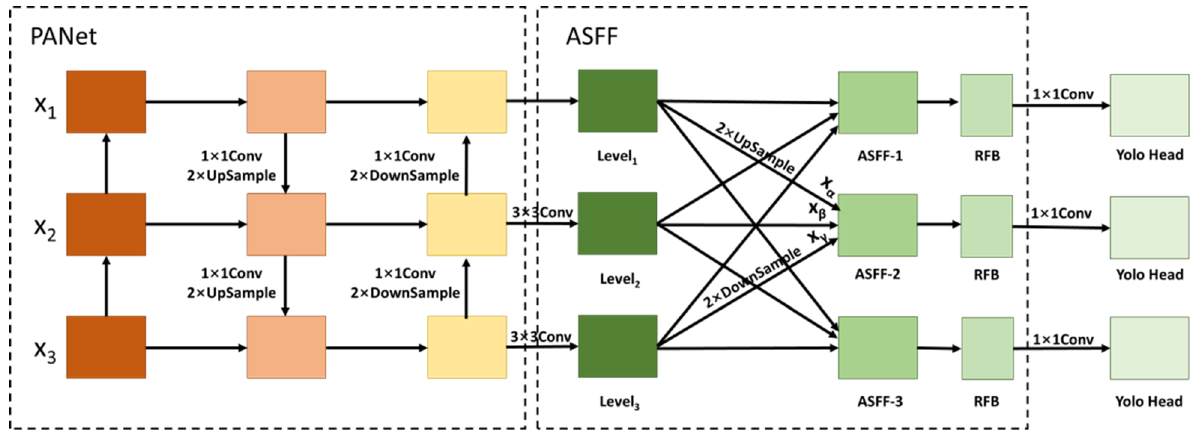
Figure 5. Integration of the PANet structure into the ASFF